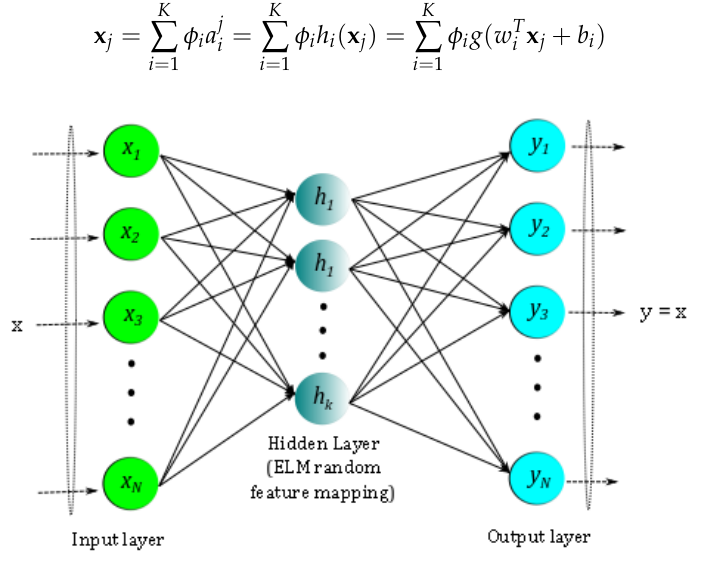
Figure 2. Schematic of the extreme learning machine (ELM) autoencoder network. In this architecture, the output features are the same as input